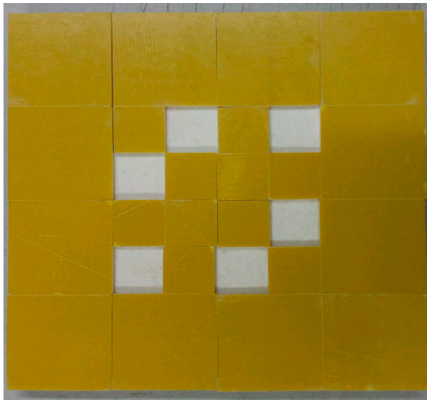
Figure 4. Sample 1 of defect.